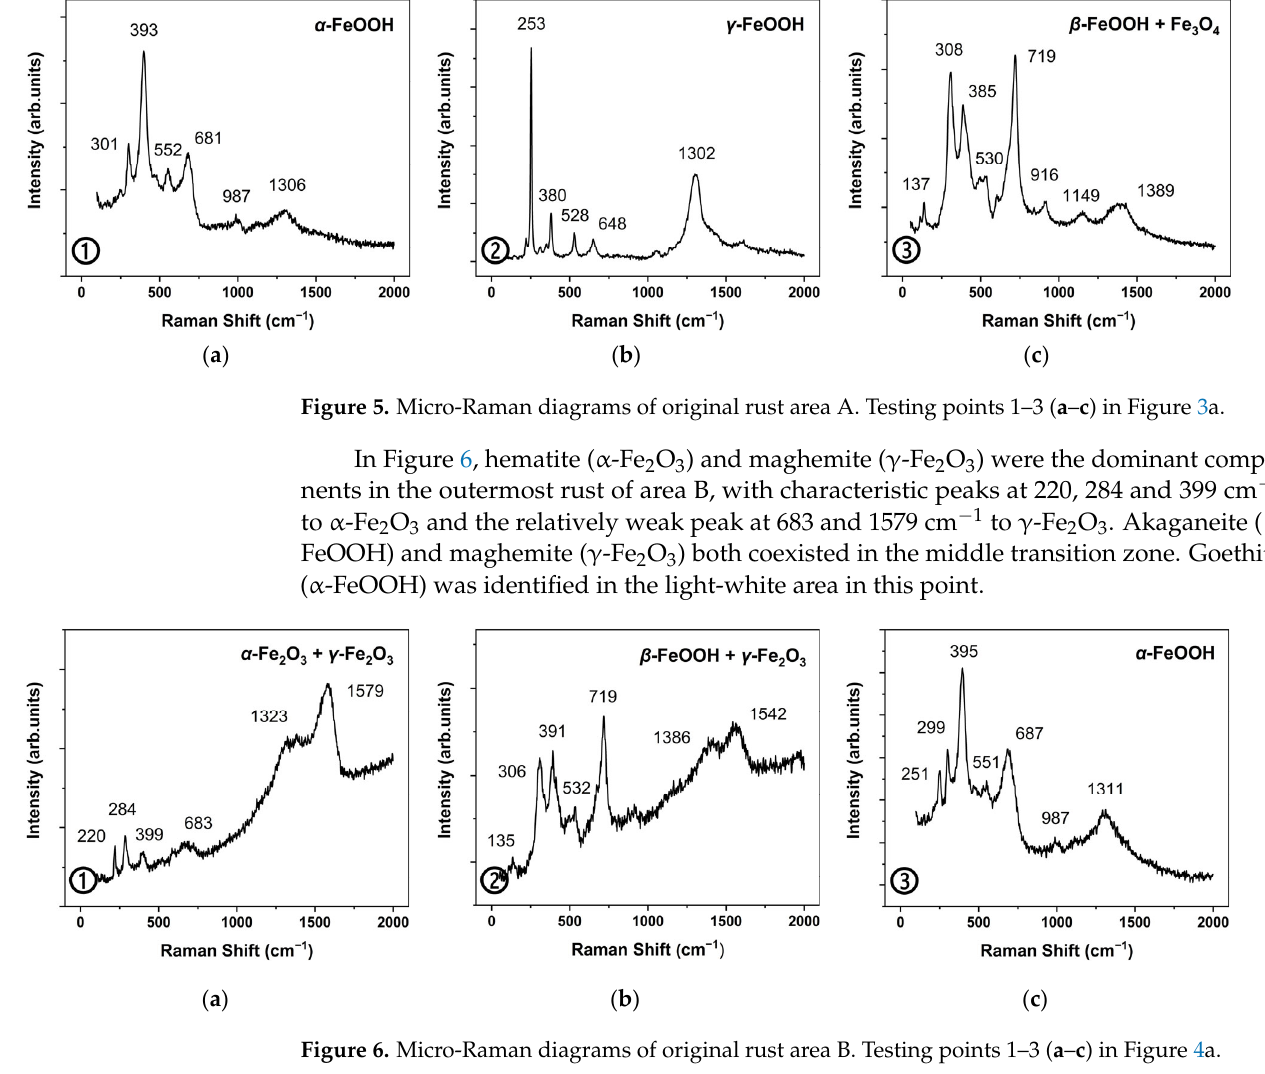
Figure 6. Micro ‐ Raman diagrams of original rust area B. Testing points 1–3 ( a – c ) in Figure